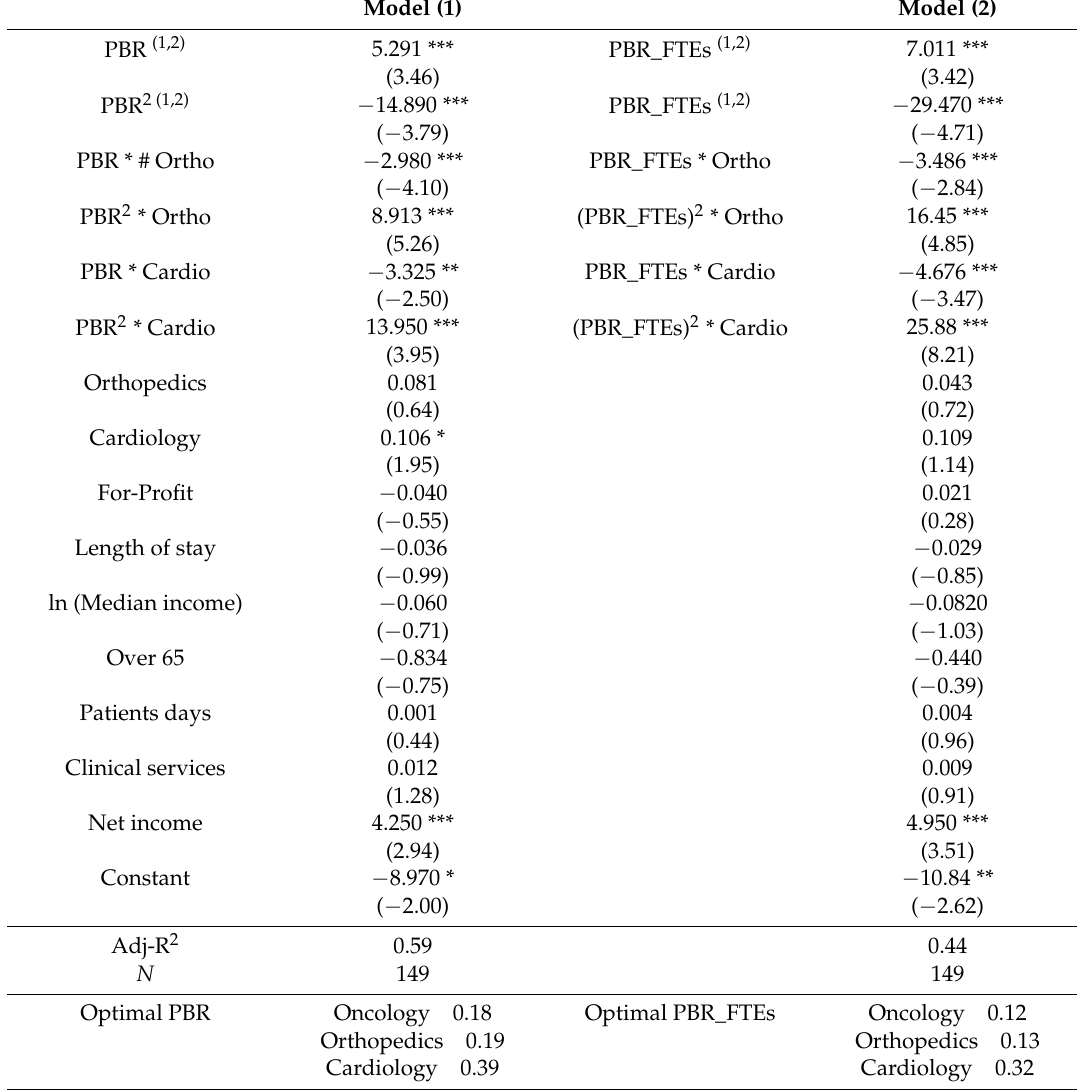
Table 3. Regression analysis including interaction effects of the physicians-per-bed ratio with the different specialties. Dependent variable: Ln ( IHQ